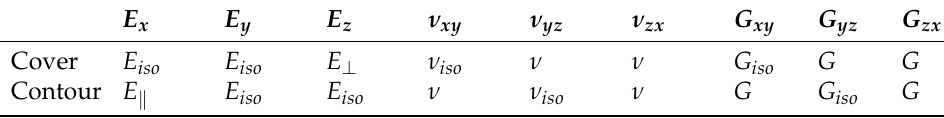
Table 1. Cover and contour properties’